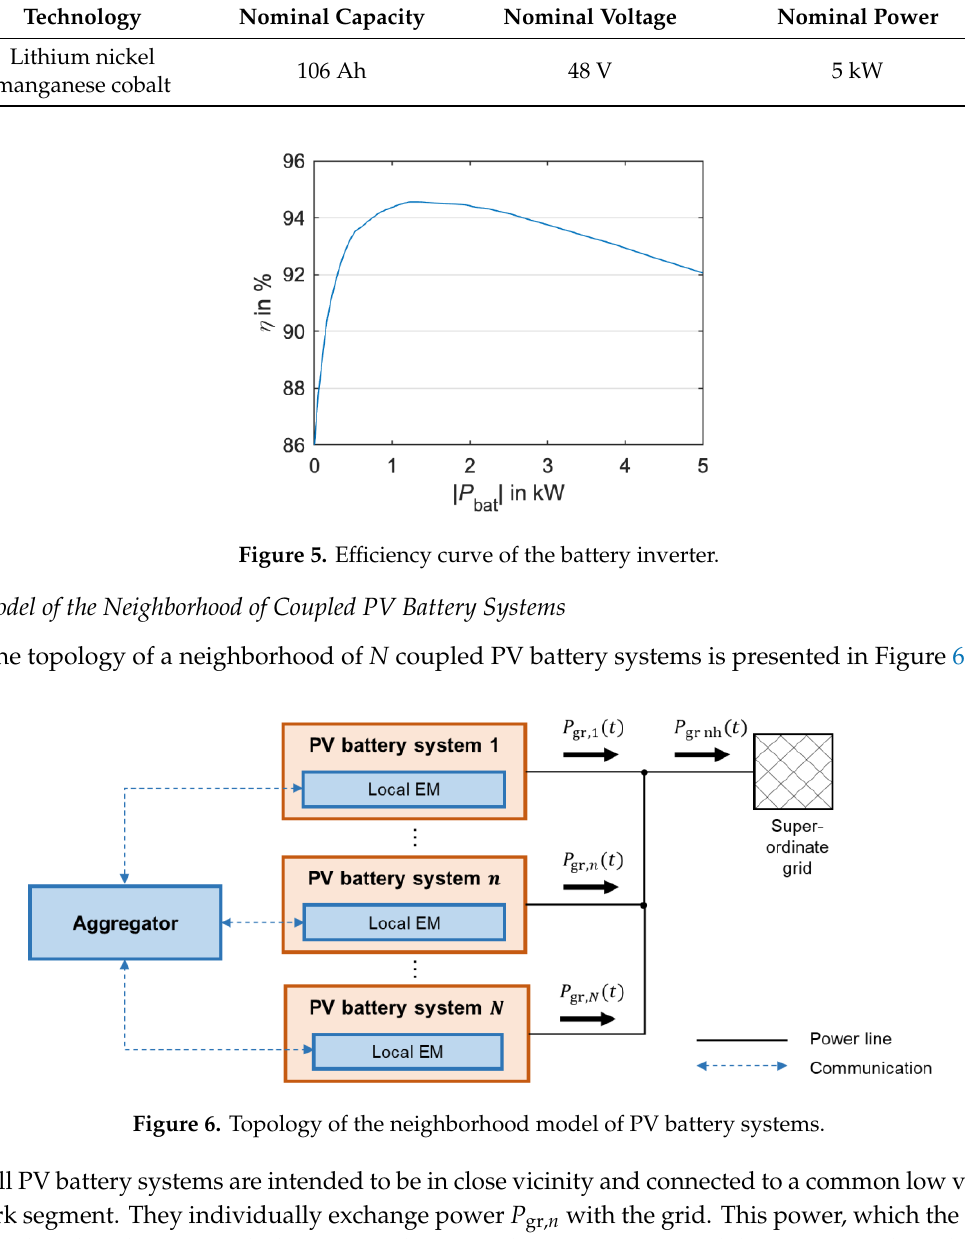
Figure 6. Topology of the neighborhood model of PV battery systems. Table 2. Relevant power flows of the neighborhood of PV battery systems.